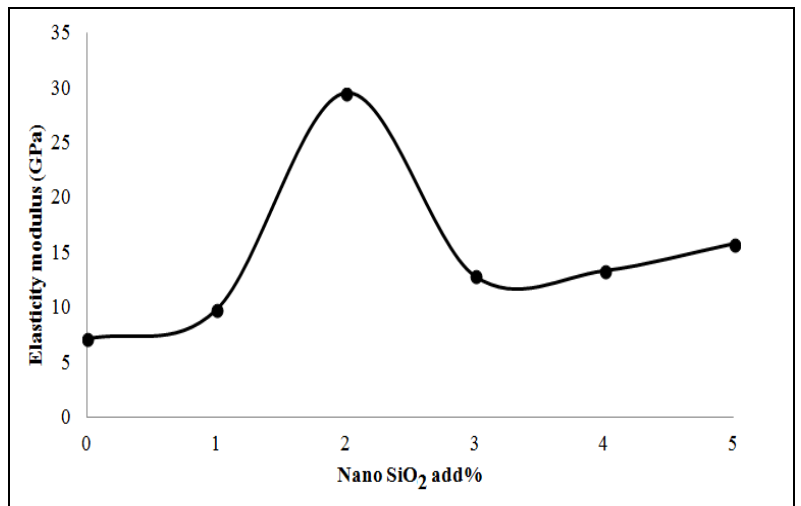
Fig.12: Elasticity modulus with filler for all samples.